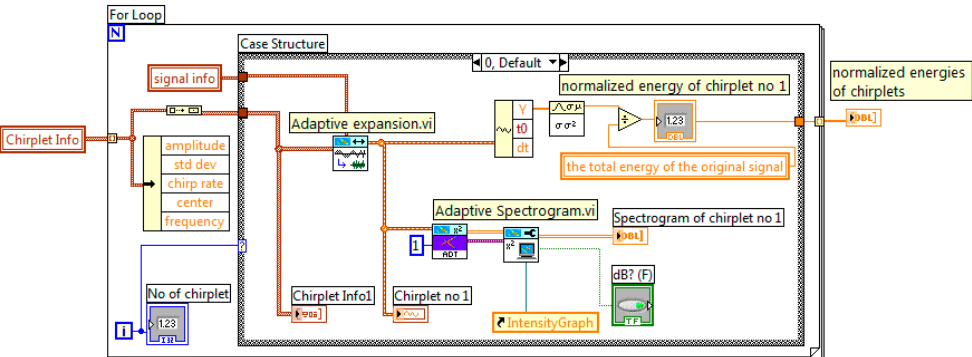
Figure 7. The part of the block diagram of the virtual analyzer, which calculates the normalized energy of each chirplet and computes its time-waveform and spectrogram.